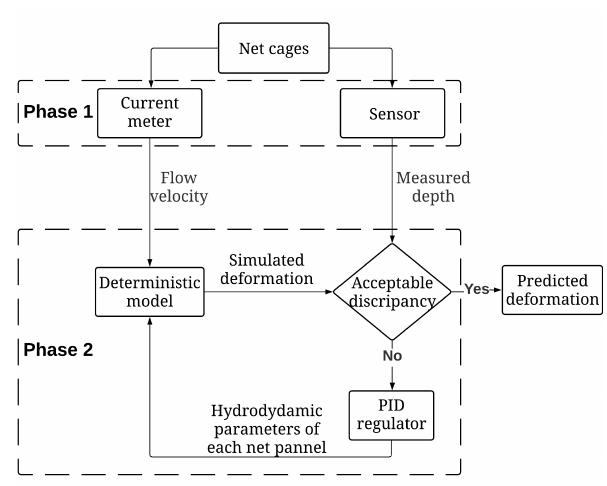
Figure 2: The general scheme of integrating measured depth data with a deterministic cage